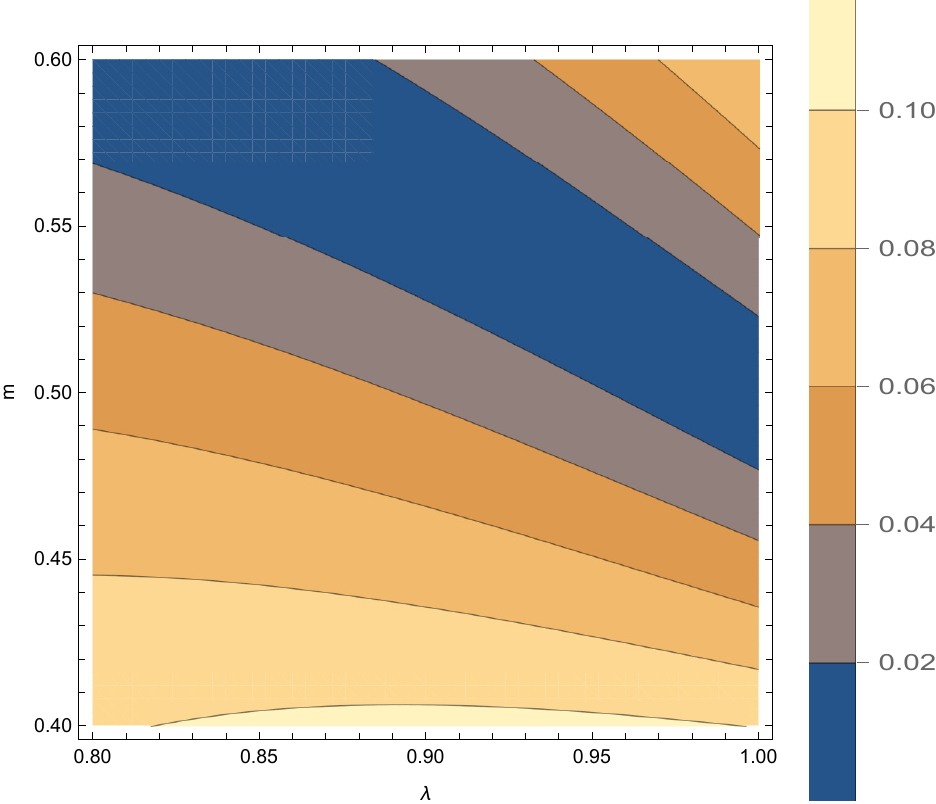
Figure 11. Contours of a neighborhood of the Puig-Adam’s choice of parameters where la Cierva’s surface behaves